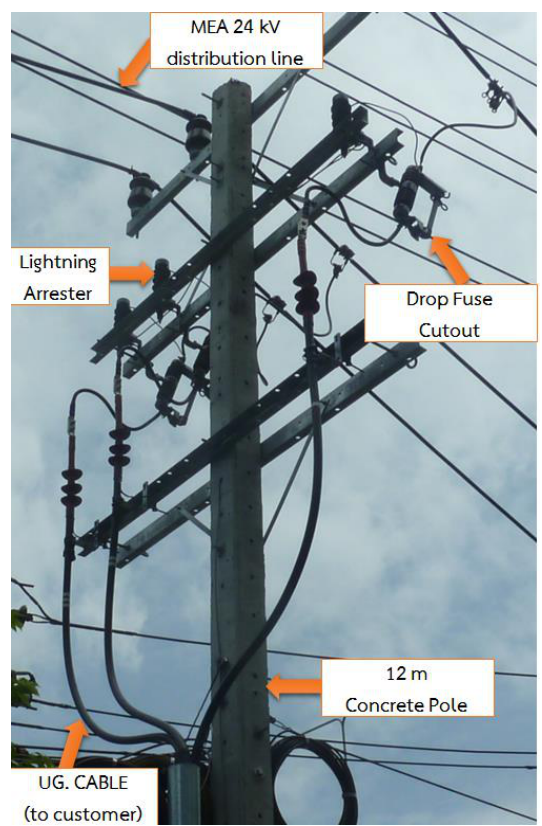
Figure 25. Pole structure at point A that is situated between the overhead distribution line and the underground cable.